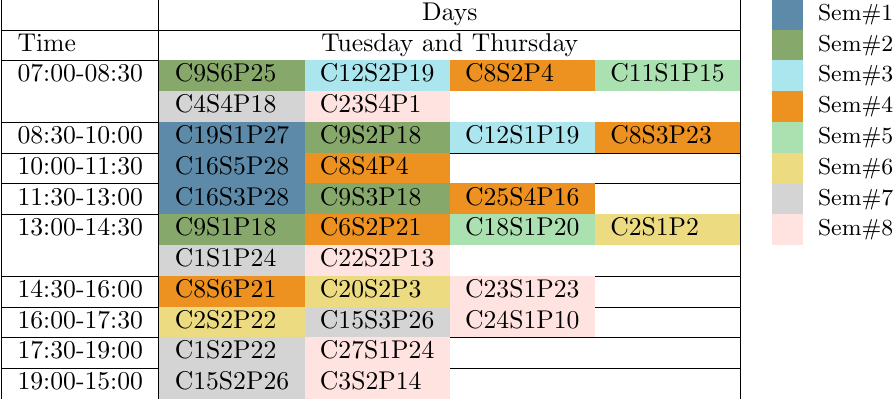
Figure 7. Timetable of third strategy for courses in day scheme B: Tuesday and Thursday, two classes of 1 h and a half per